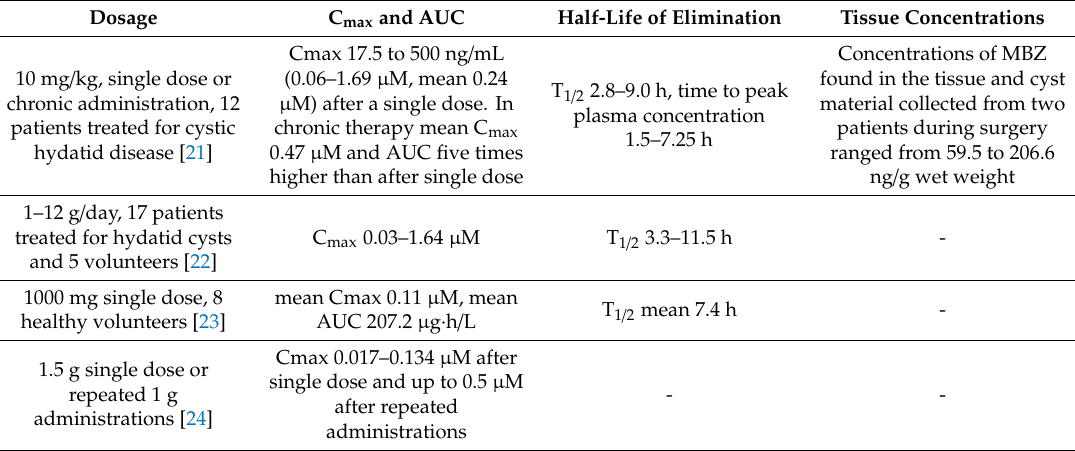
Table 1. Pharmacokinetic studies in patients treated for hydatid disease. Cmax = peak serum concentration AUC = area under the curve T1 / 2 = elimination half-life. Dosage C max and AUC Half-Life of Elimination Tissue